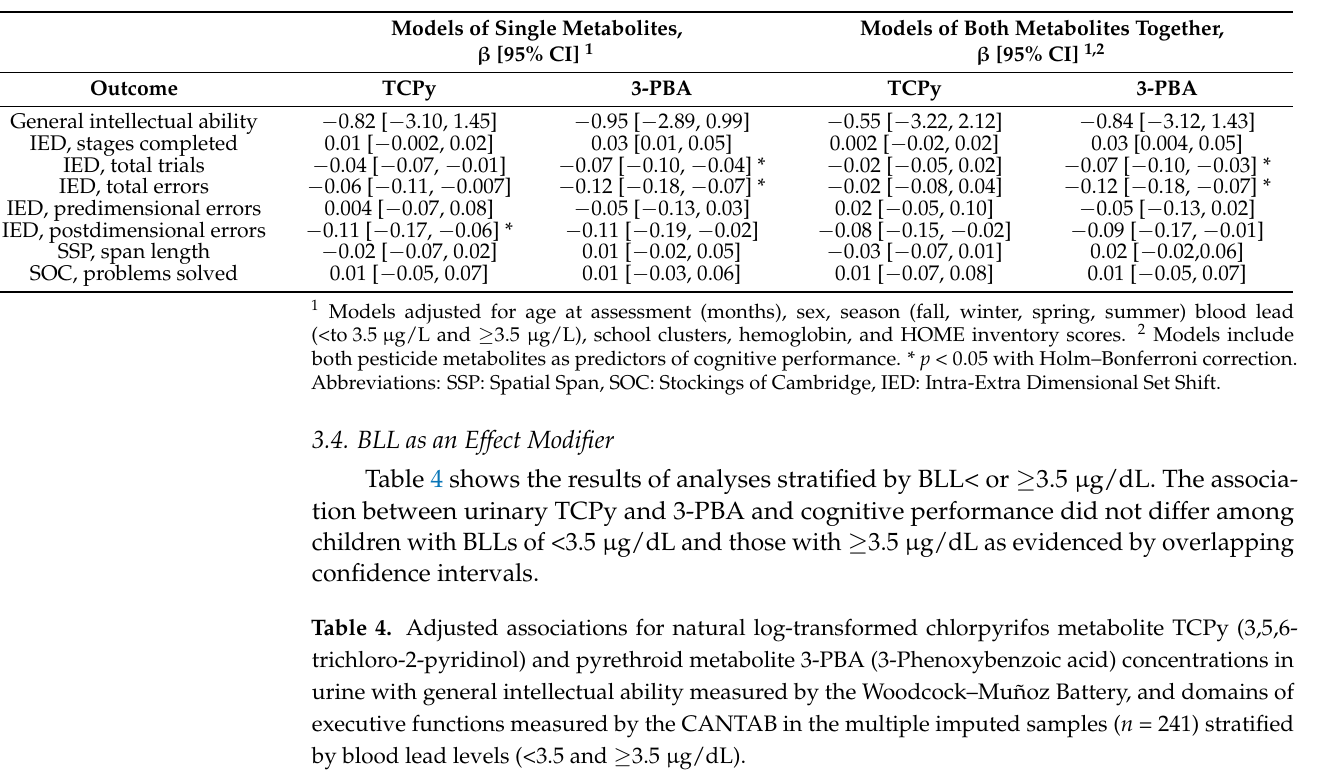
Table 3. Adjusted associations for natural log-transformed chlorpyrifos metabolite TCPy (3,5,6- trichloro-2-pyridinol) and pyrethroid metabolite 3-PBA (3-Phenoxybenzoic acid) concentrations in urine with general intellectual ability measured by the Woodcock–Muñoz Battery, and domains of executive functions measured by the CANTAB in the multiple imputed samples ( n = 241).